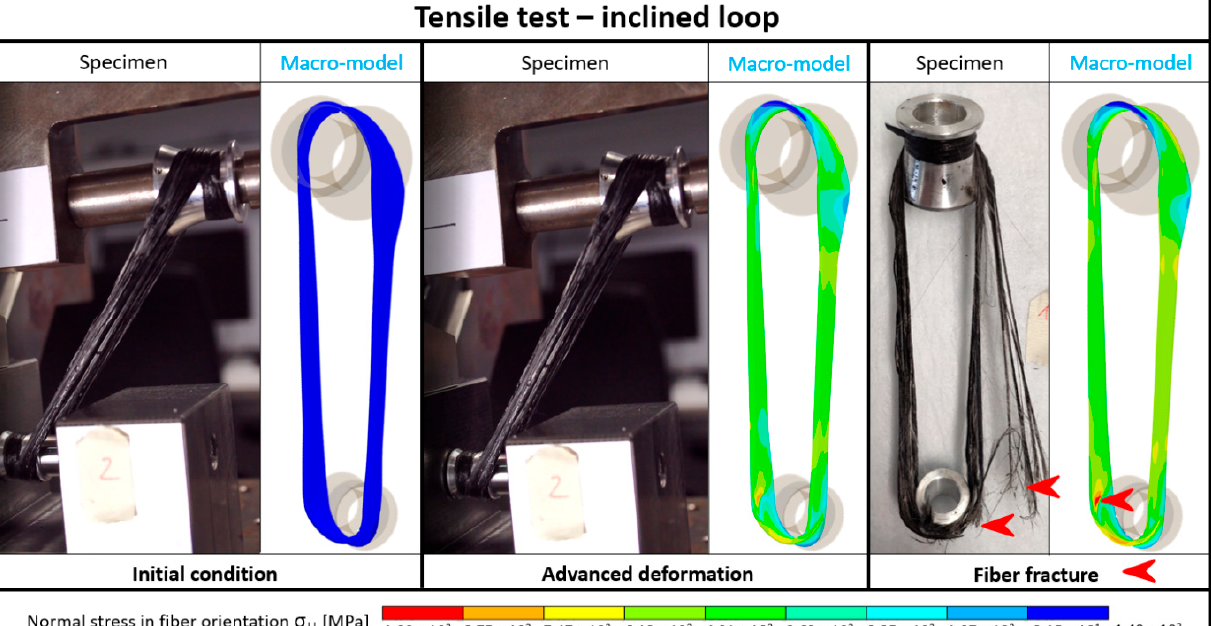
Figure 24. Sliding processes at the inserts of the inclined loop (specimens and model). 4. Conclusions In the present work, a systematic approach for FE analysis of thermoplastic impreg- nated fiber skeletons, initially presented in [21], was advanced and validated. The meso- level geometry modeling procedure was supplemented by further characteristic dimen- sions whose mechanical influence was subsequently investigated using the example of simple loops. From the results obtained, recommendations for more complex modeling tasks could be derived. With regard to more time-efficient modeling and simulation, the geometry modeling was transferred to the macroscopic level. In a comparison of meso- and macro-modeled simple loops, the application areas of the two approaches were dis- tinguished. Being able to reproduce fiber fracture as well as delamination, meso-models have the potential to provide accurate predictions of deformation and failure for all spec- imens studied in this paper. Macro-models have the advantage of reduced modeling and computational effort but cannot reproduce delamination and may therefore provide inac- curate results for fiber skeletons that are prone to local or total detachments. These simu- lation-based findings were confirmed by experimental tensile tests on simple loop speci- mens. Consequently, it is recommended to rely on macro-modeling only, as long as no major delamination is expected. If this cannot be assured, modeling at the meso-level is required. Based on this finding, the procedures and models developed up to this point